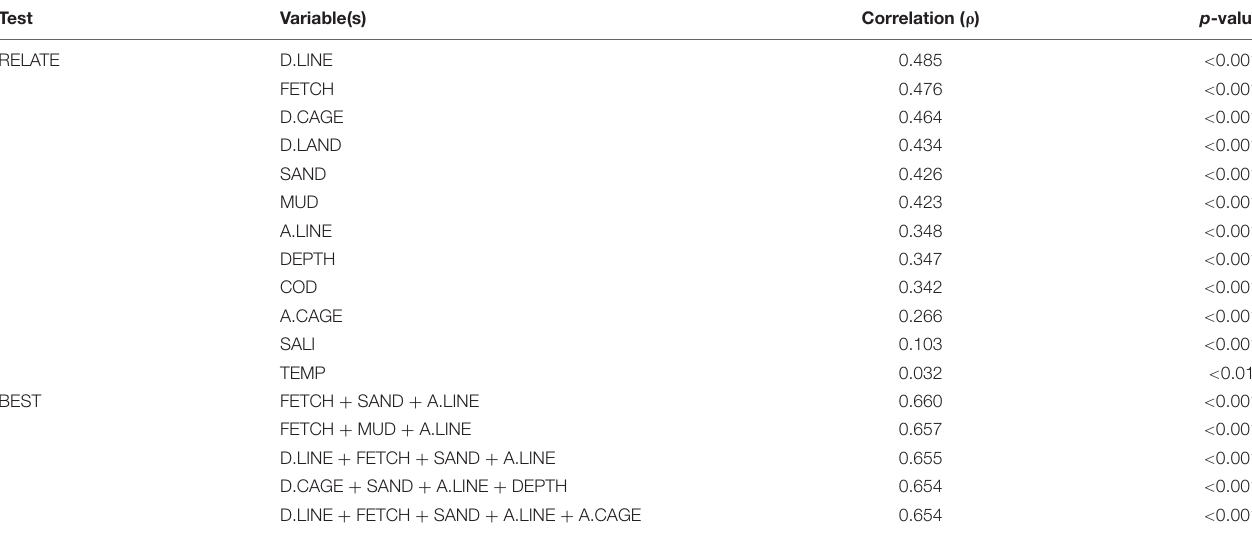
TABLE 4 | Results of RELATE tests (upper 12 rows) and BIO-ENV stepwise (BEST) analysis (lower 5 rows) showing Spearman’s rank correlation coefficients ( ρ ) between benthic macrofaunal community structure and the environmental variables (coding of environmental variables as in Table 1 ). Test RELATE